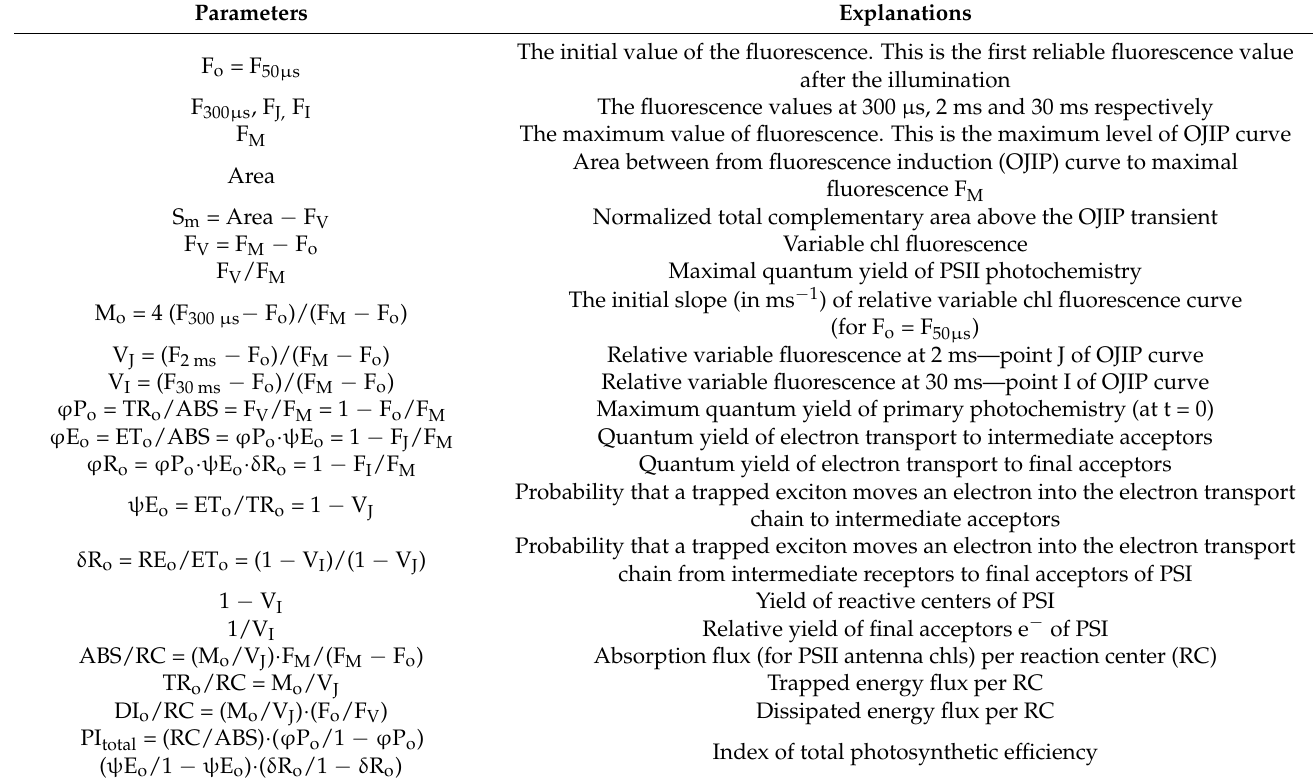
Table 1. The selected parameters derived from the fast OJIP fluorescence induction with their explanations and